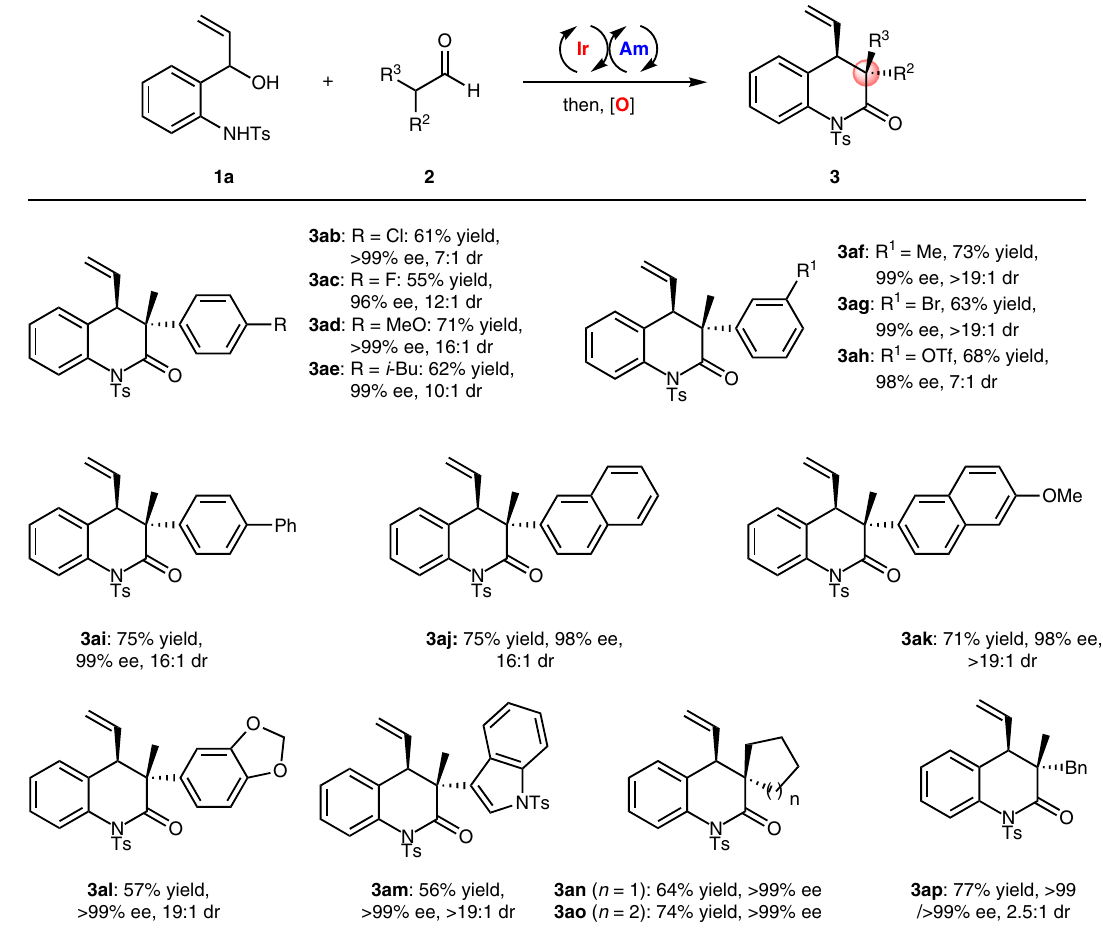
Fig. 3 Synthesis of dihydroquinolinones from various aldehydes. Reaction conditions: as indicated in entry 1 in Table 1; isolated yield; the ee and dr values were determined by chiral HPLC